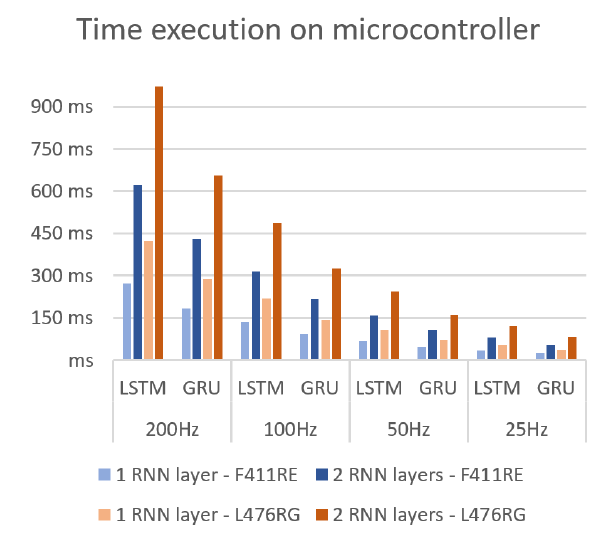
Figure 7. RNN model execution